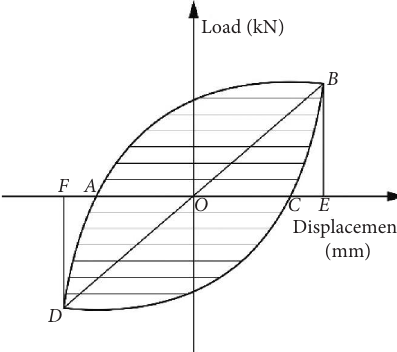
Figure 14: Sketch of the energy dissipation coefficient. Table 5: /e results of the energy dissipation